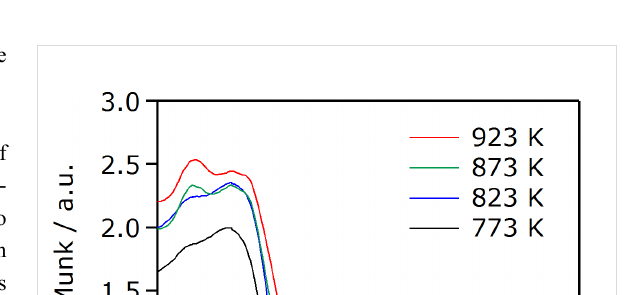
Figure 3: TEM images of g-C 3 N 4 synthesized at different temperatures.